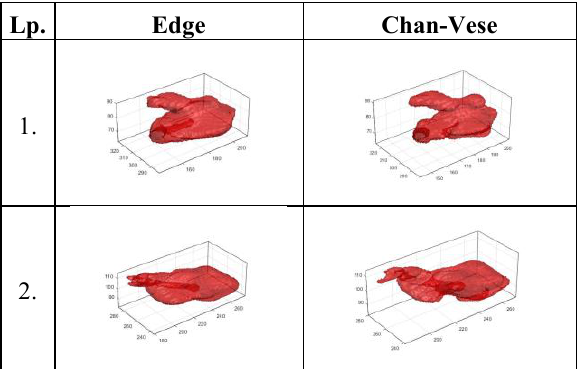
Table 1. The visualizations of identified tumours.